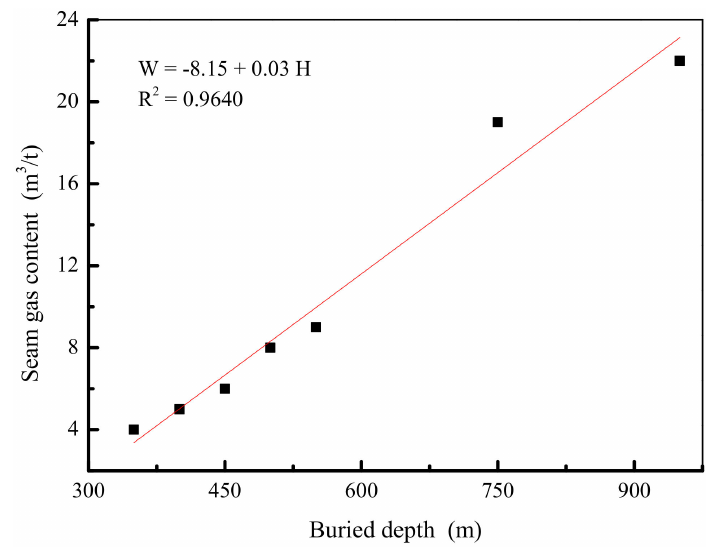
Figure 7. Relationship diagram of the coal gas content and depth. The upper Ding and the lower coal seams corresponding to the working face are not recovered, and the proximate analysis and coal type of group coal are shown in Table 3. The elevation of 20,180 working face is − 510~ − 570 m, the thickness of coal seam is 1.1–1.6 m (the coal seam histogram is shown in Figure 8), the coal seam inclination angle is 10 ◦ –14 ◦ , the effective strike length is 915 m, and the mining length is 200 m. The measured gas content of the mining face is 15 m 3 /t, the gas pressure is 1.2 MPa, and the gas permeability coefficient of the coal seam is about 0.005–0.08 mD.